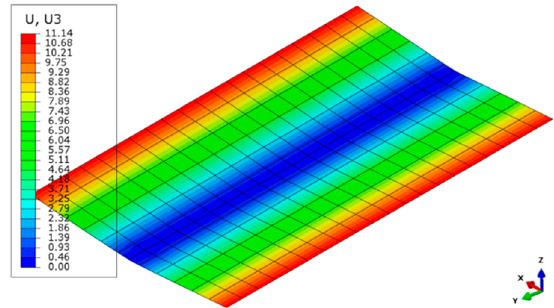
Table 7. Input variables for multi-pass SDB method.